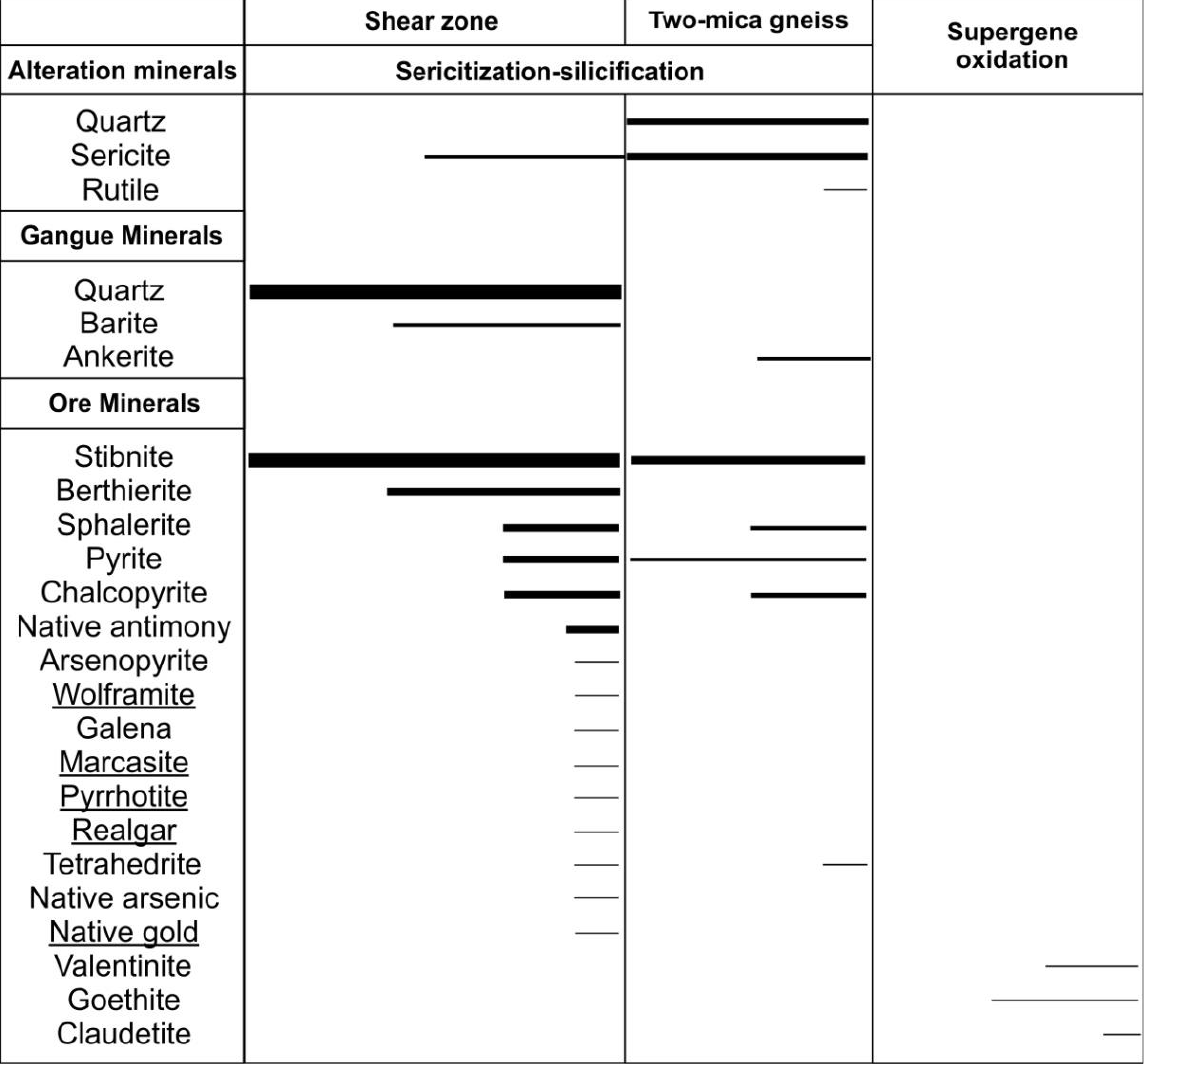
Figure 8. Alteration, gangue and ore minerals of the Sb-mineralization located at “Tas-Kapou”. The underlined ore minerals are described by Dimou [32] occurring as traces in the stibnite ore. They are included here for consistency. Line thickness depicts the relative abundances of the minerals.